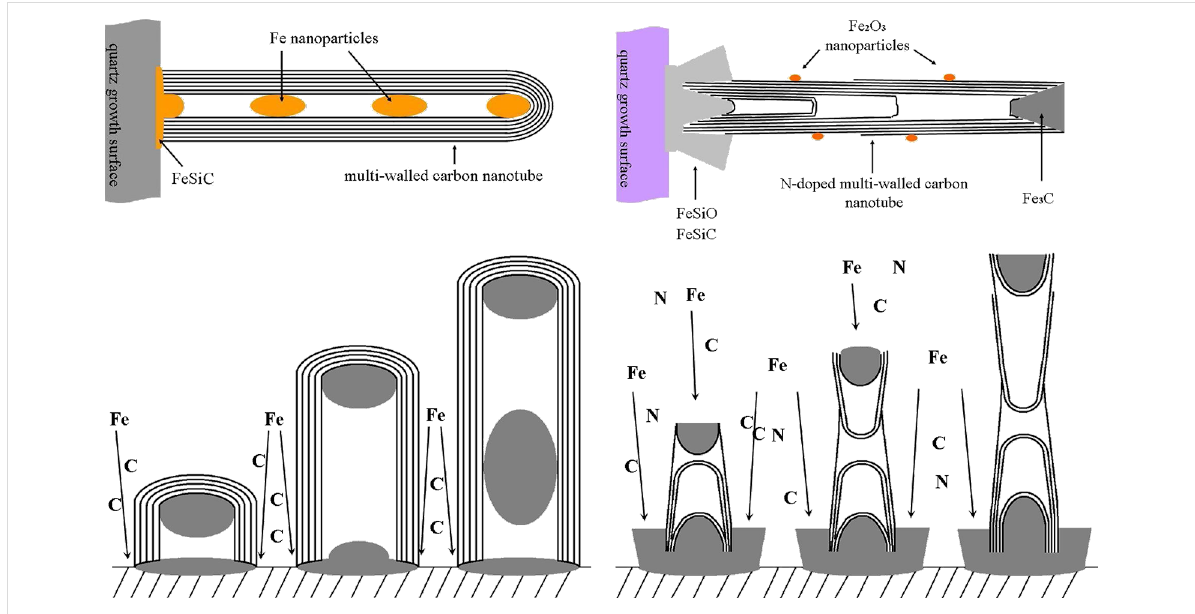
Figure 12: Models of MWCNT (left) and N-CNT (right) with metal particles differently distributed along the nanotube core (upper panel) and schematic presentation of a possible growth model for ‘base’ growth mechanism of MWCNTs and ‘mixed base and tip’ growth mechanism of N-CNTs (lower